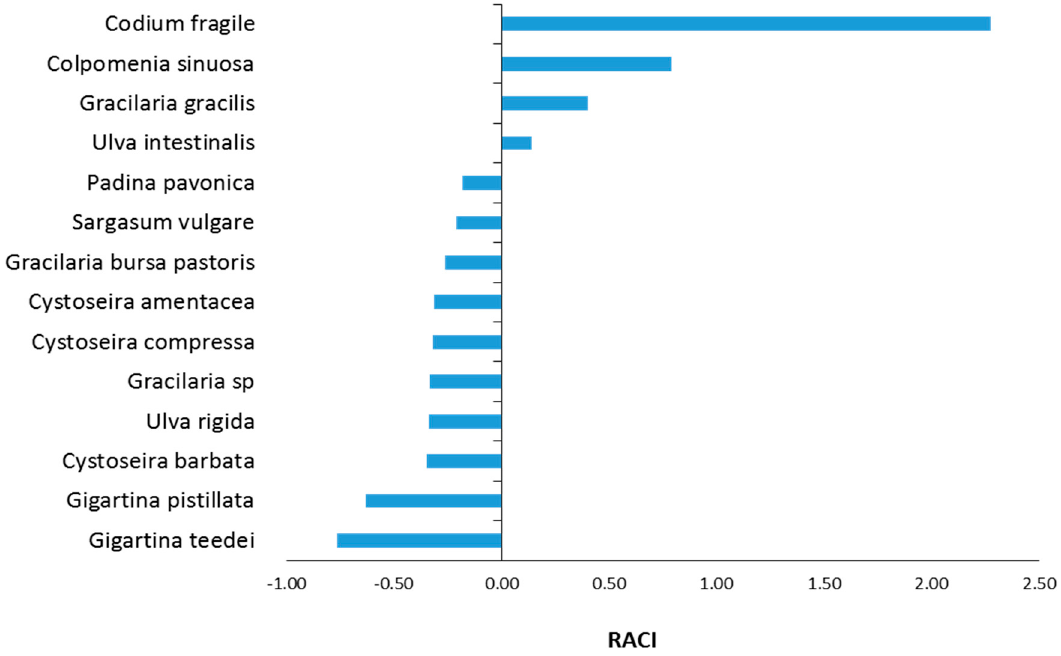
Figure 5. Potency order of macroalgae extracts’ antioxidant activity based on RACI values.